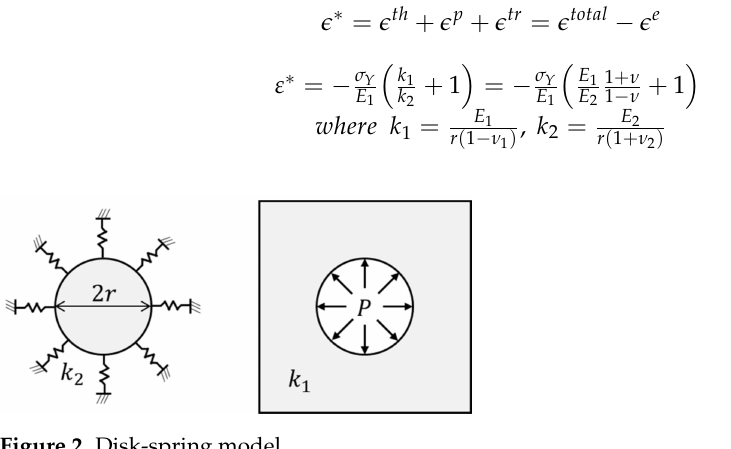
Figure 2. Disk-spring model.